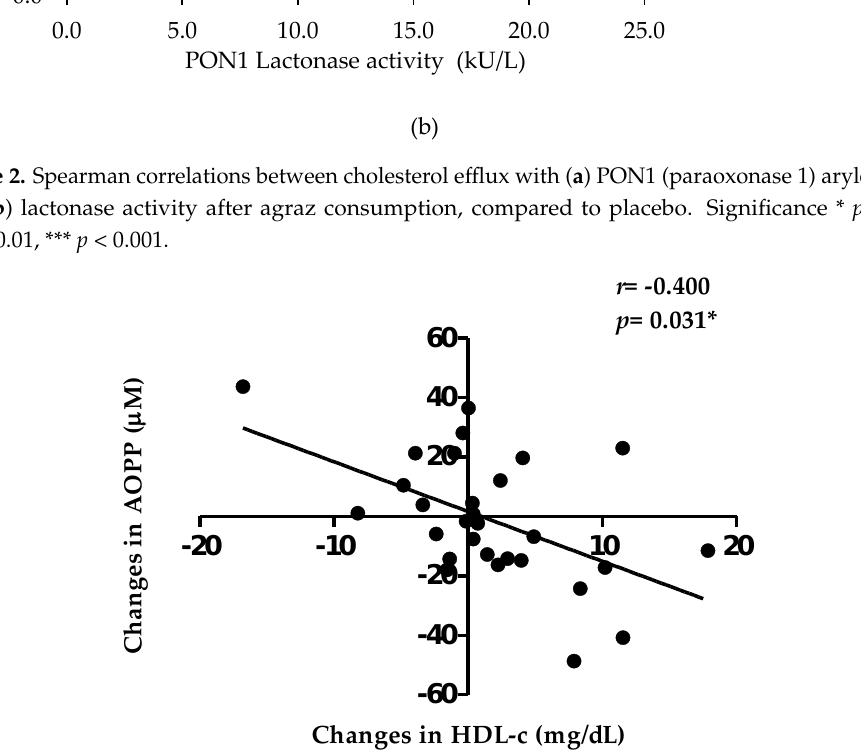
Figure 3. Pearson correlation between changes in high-density lipoprotein cholesterol (HDL-c) and advanced oxidation protein products (AOPP) after agraz consumption, compared to placebo. Significance * p < 0.05.